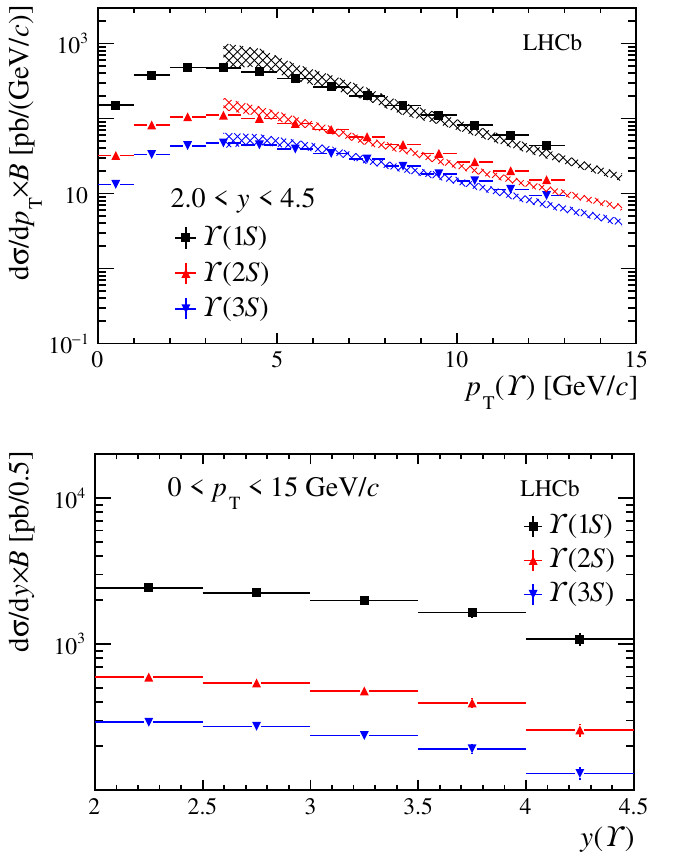
Figure 3 . Di(cid:11)erential cross-sections multiplied by dimuon branching fractions for the (cid:7) (1 S ) (black solid squares), (cid:7) (2 S ) (red upward triangles) and (cid:7) (3 S ) (blue downward triangles) states (top) versus p T integrated over y between 2.0 and 4.5 and (bottom) versus y integrated over p T from 0 to 15 GeV =c . Statistical and systematic uncertainties are added in quadrature. Predictions from NRQCD [24] for the (cid:7) (1 S ) (black grid shading), (cid:7) (2 S ) (red grid shading) and (cid:7) (3 S ) (blue grid shading) states are overlaid in the top